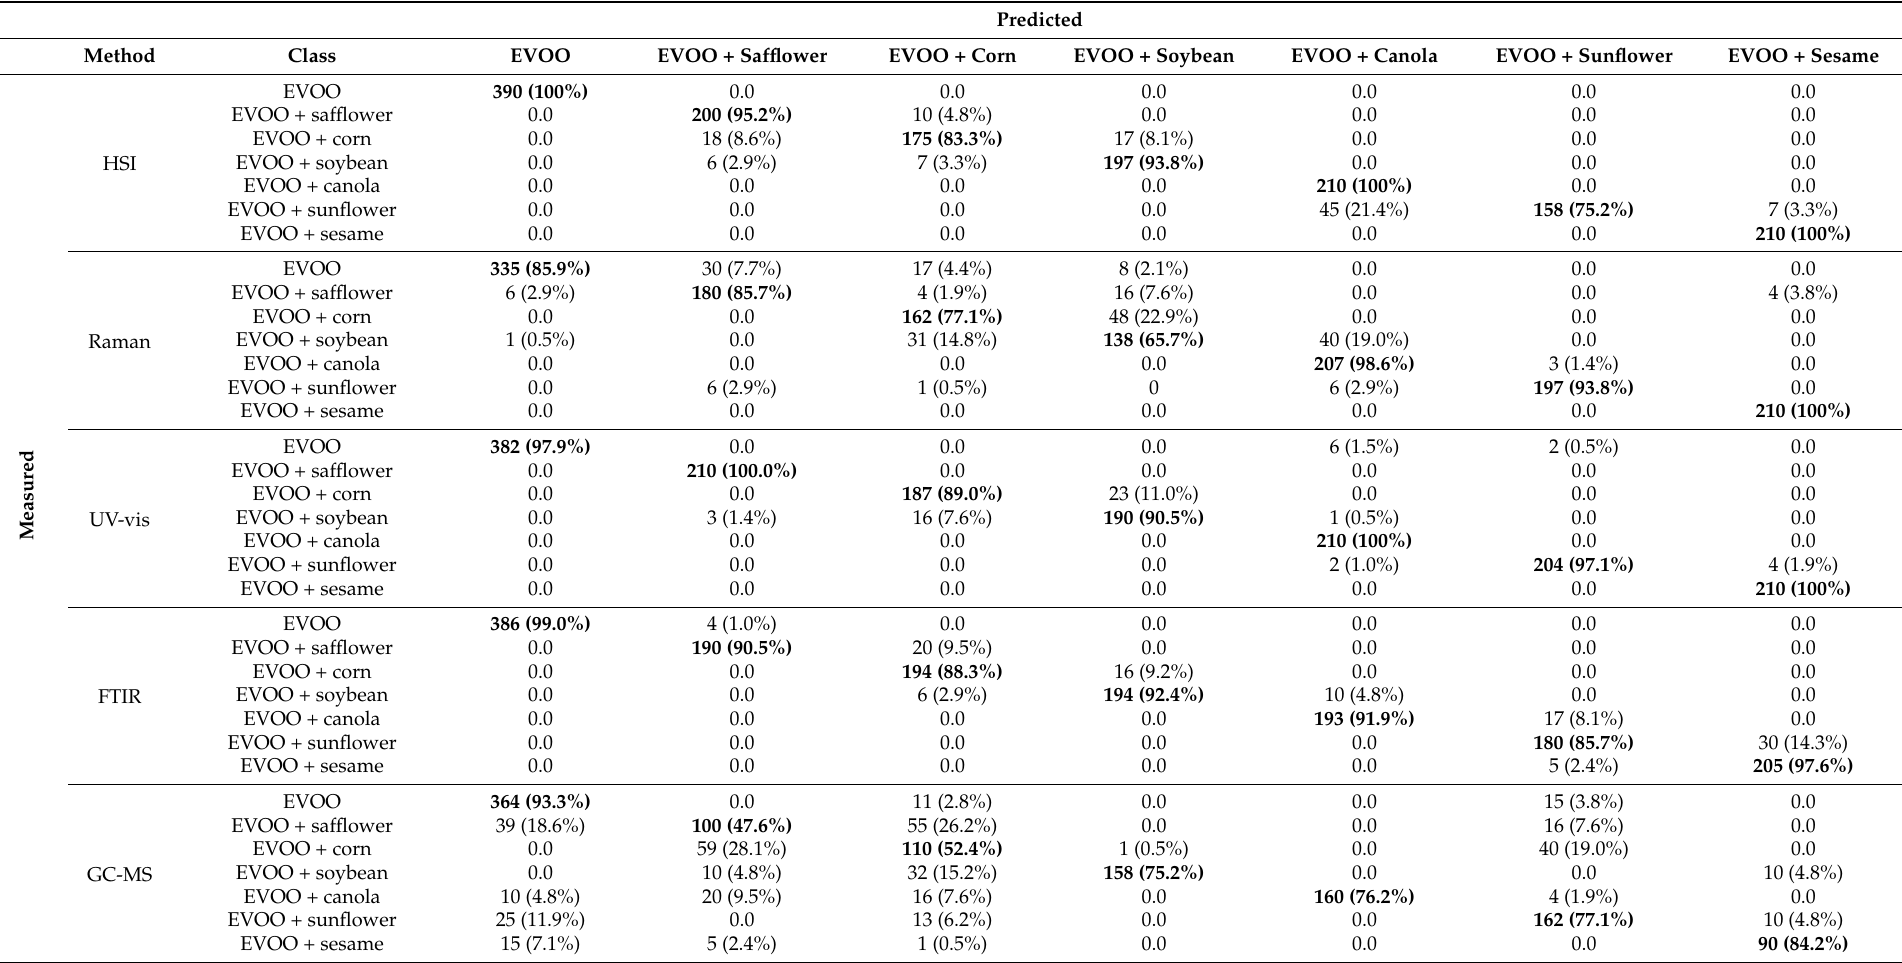
Table 4. PLS-DA classification (testing/validation data) of EVOO and EVOO adulterated with different edible oil